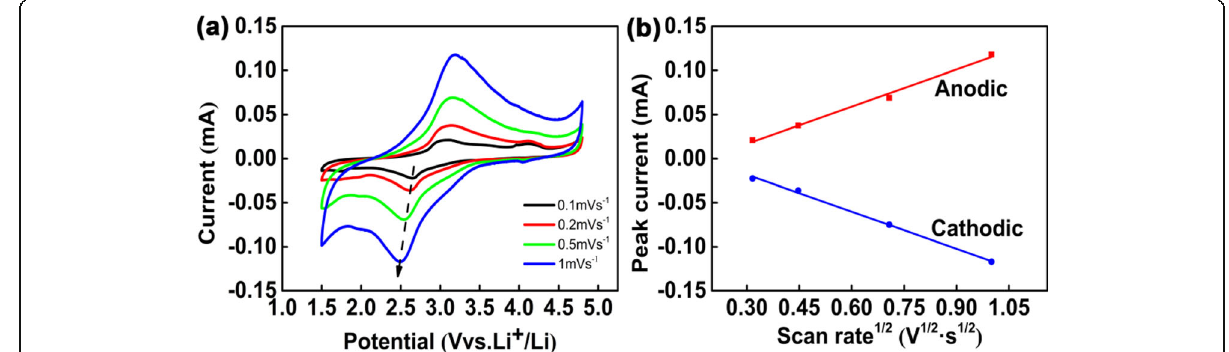
Fig. 5 Kinetic analysis of CNT@Li 2 FeSiO 4 @C using CV. a CV profiles at various scan rates. b peak current as a function of square root of scan